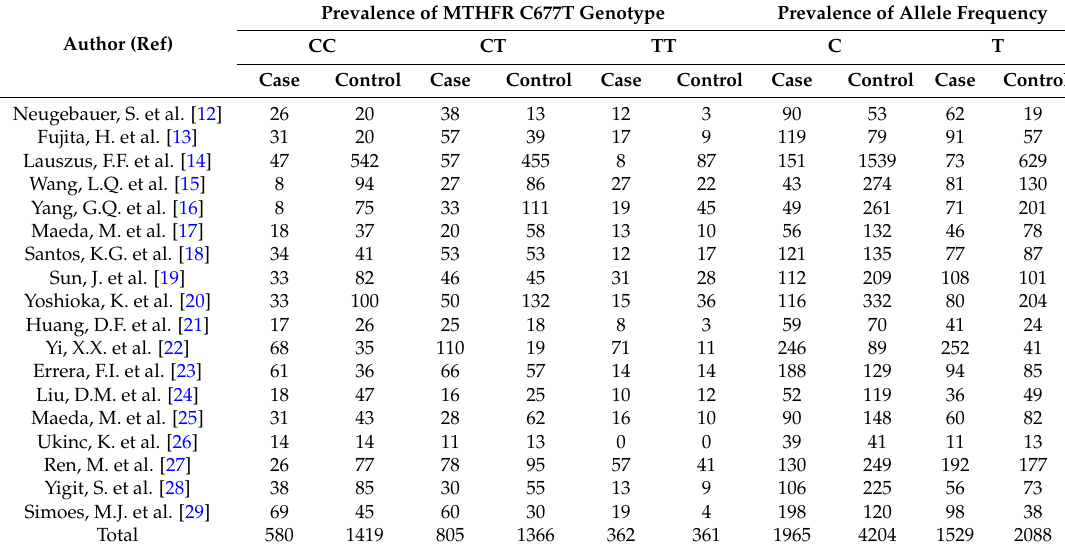
Table 2. The frequency of methylenetetrahydrofolate reductase gene ( MTHFR ) C677T polymorphism allele/genotype